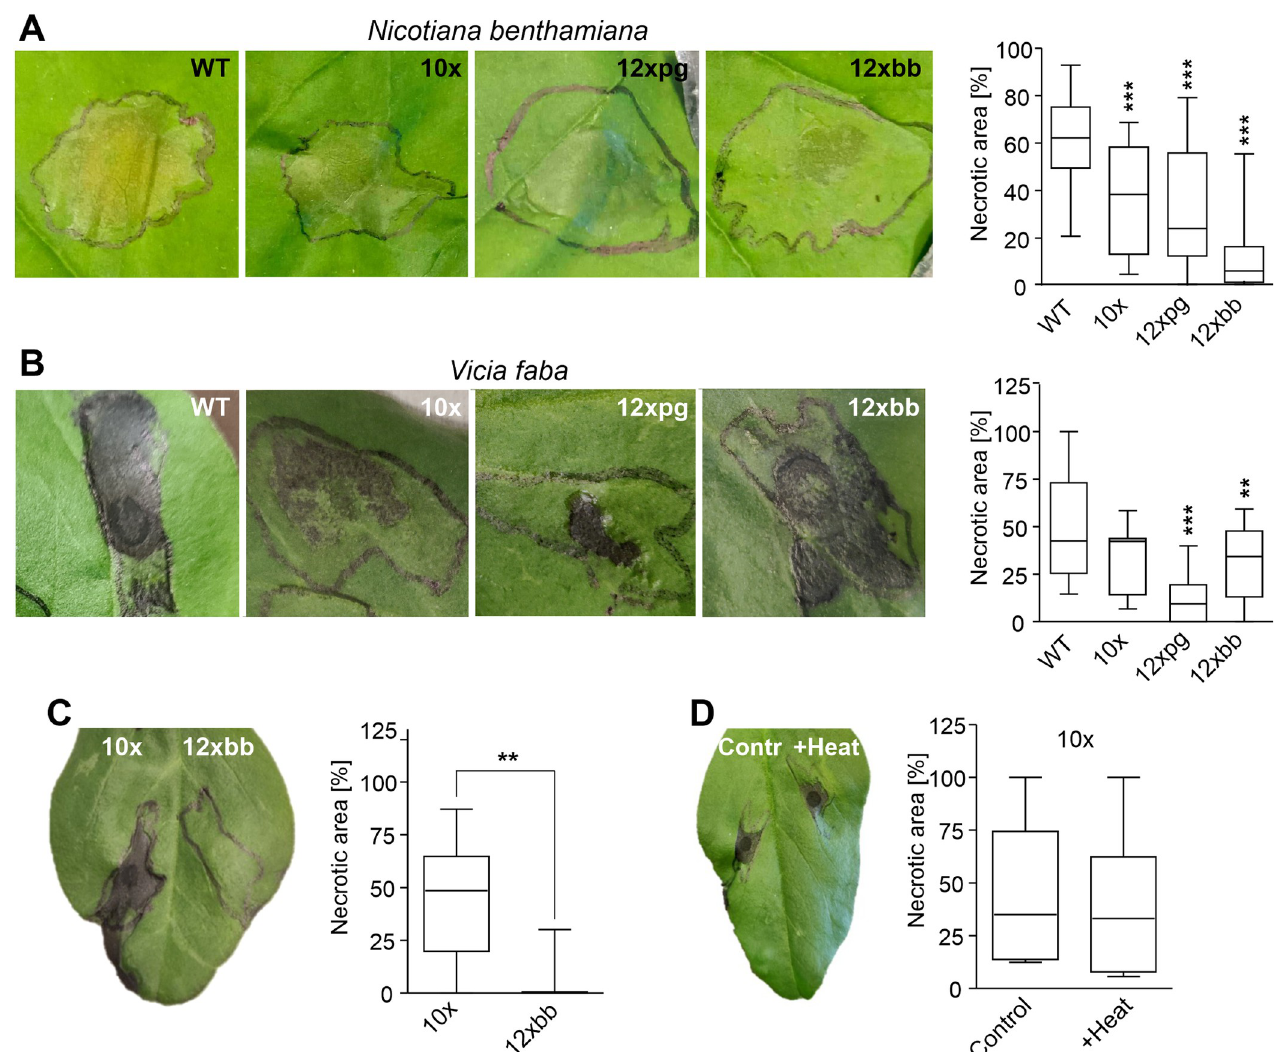
Fig 5. Phytotoxic activity of B . cinerea secretomes after leaf infiltration. A-B: Necrotic lesions caused by WT and mutant secretomes (2 μ g ml -1 ) in infiltrated tobacco (A) and faba bean (B) leaves after three days. Values are the means of at least three experiments and two or three leaves per experiment. One- way ANOVA and Dunnett´s post hoc test (control: WT); �� p < 0.01; ��� p < 0.001; n � 15 (tobacco) and n � 8 (faba bean). C: Cell death inducing activity on faba bean leaves of non-proteinaceous ( < 10 kDa) secretome fractions of a 10x mutant and a 12xbb mutant unable to synthesize botrydial and botcinins (n = 6). D: Effects of heating (95˚C for 20 min) on CDI activity of the non-proteinaceous fraction of the 10x mutant (n = 6). C, D: Two-tailed t test, �� p < 0.01.